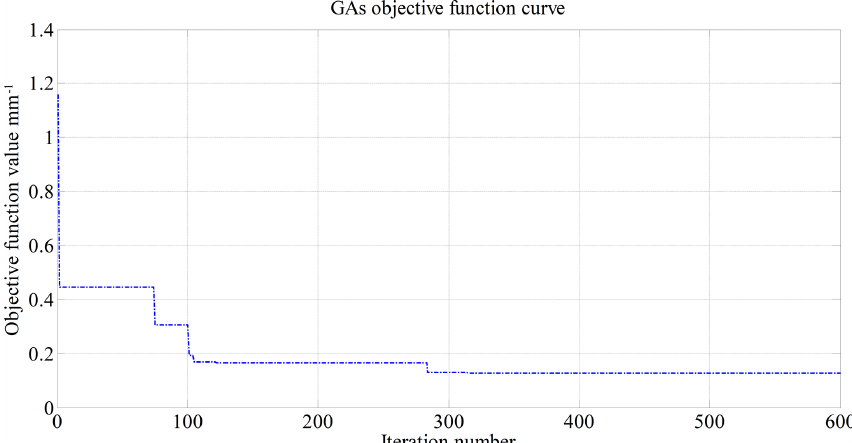
Figure 8. Optimization curve of the GAs